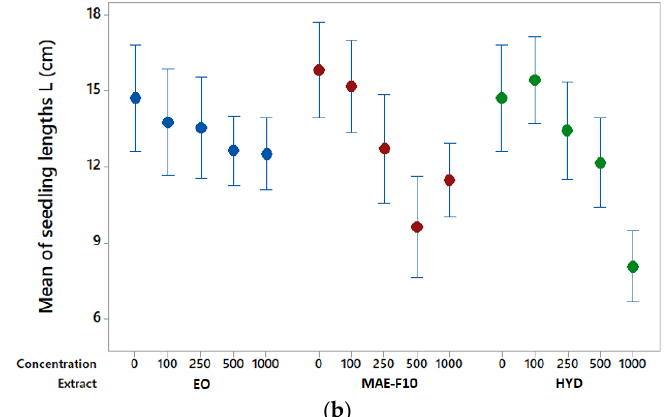
Figure 5. Effect of X. spinosum extracts on seed growth. Data displayed is the mean of three replicates of 10 seeds each, individual standard deviations were used to calculate the intervals. Mean of seedling lengths (L) were measured after an incubation time of 7 days at 20 °C in the dark using seeds of ( a ) Allium porrum (monocot plant) and ( b ) Raphanus sativus (dicot plant). Seeds were treated using five extract concentrations from 0 (control) to 1000 µg.mL − 1 . EO: essential oil, HYD: hydrosol extract, MAE-F10: rich-lactone fraction obtained by CC from MAE.